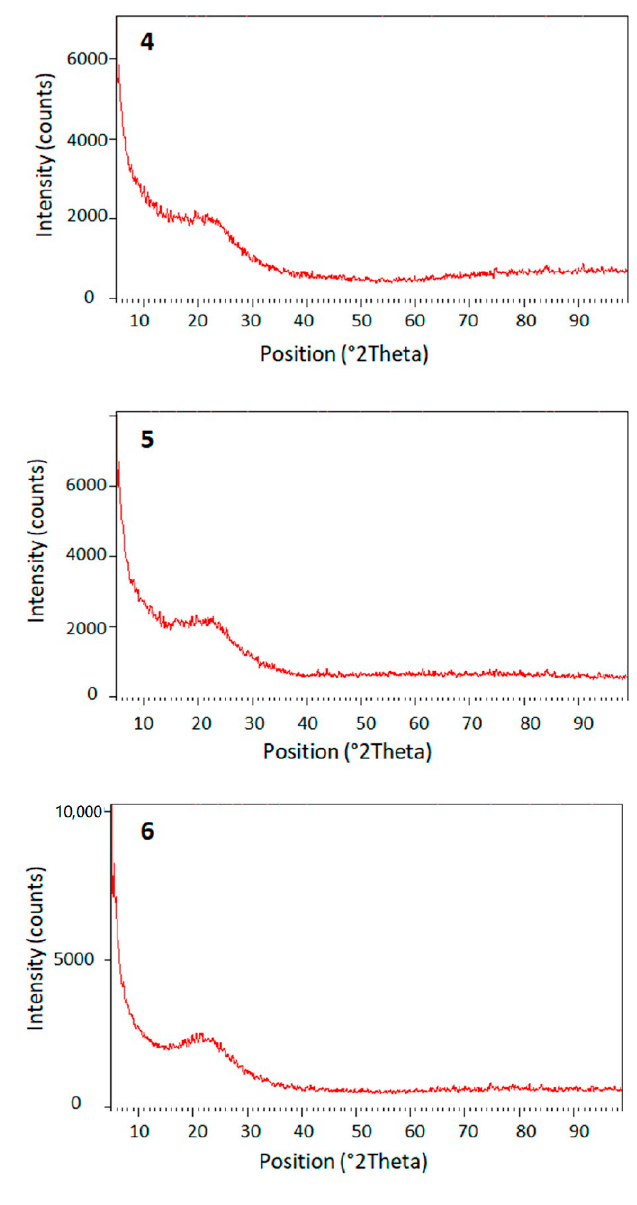
Figure 2. Powder XRD pattern of polymers 4–6 .